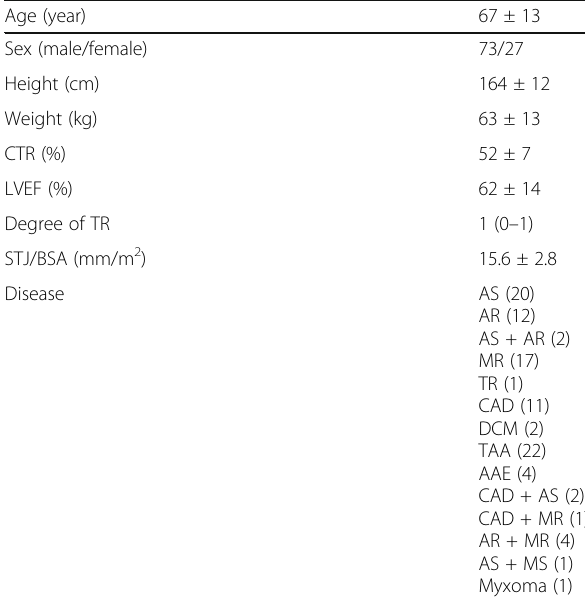
Table 1 Summary of 100 patients